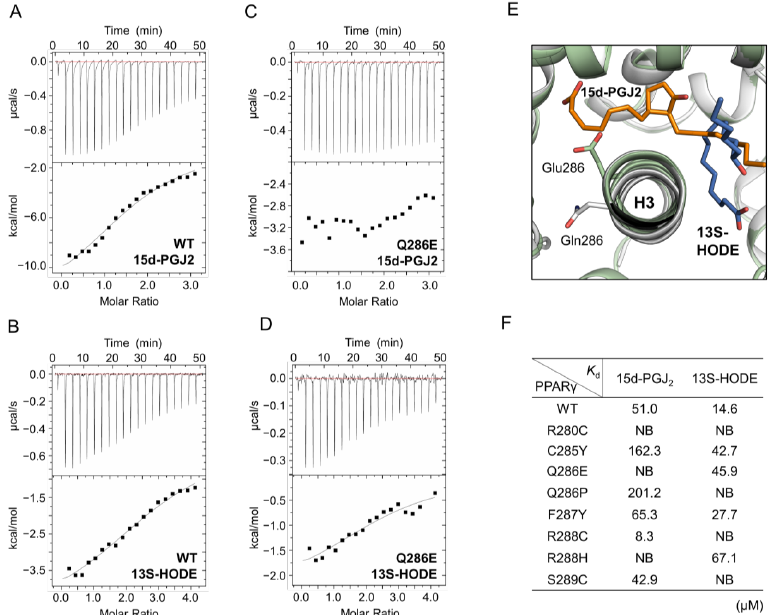
Figure 5. The binding affinity of PPARγ LBD for endogenous ligands. ( A – D ) ITC profiles for PPARγ LBD WT and Q286E with 15d-PGJ2 ( A , C ) and 13S-HODE ( B , D ). ITC analysis is conducted by titrating the endogenous ligands at a concentration of 0.9 mM into PPARγ LBD proteins at concentrations ranging from 45 μM to 60 μM. ( E ) Superposition of PPARγ LBD WT and Q286E structures with endogenous ligands of 15d-PGJ2 and 13S-HODE. The structures of PPARγ LBD WT and Q286E are shown as cartoon representations colored in white and pale green, respectively. The residues, Gln286 (white) and Glu286 (pale green) and the endogenous ligands, 15d-PGJ2 (orange) and HODE (blue), are displayed as stick representations. The ligands from the ligand-bound PPARγ LBD structures (PDB ID: 2ZK1, 2VST) are superposed onto the PPARγ LBD WT and Q286E structures. ( F ) K D values are calculated from the fittings of the integrated molar heat upon added ligands and listed in table for PPARγ LBD WT and mutants.